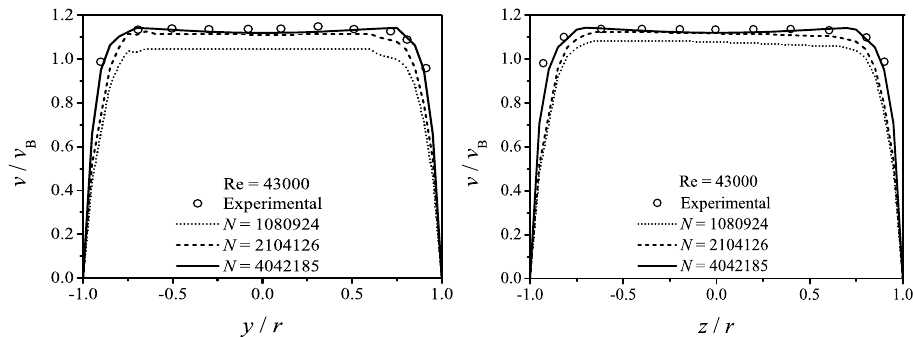
Figure 3. Numerical horizontal ( left ) and vertical ( right ) streamwise velocity profiles for N = 1,080,924, 2,104,126 and 4,042,185 particles as compared with the experimental data at S 2 = 0.58 D upstream of the bend inlet for Re = 43,000. Asymptotic convergence of the numerical solution to the experimental measurements is obtained for N = 4,042,185 SPH